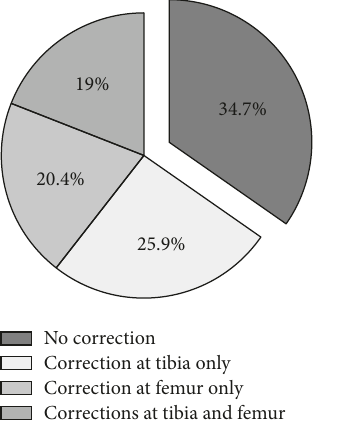
Figure 2: Change of surgical procedure due to the intraoperatively acquired data of the navigation system, presented as percentage of all arthroplasties.